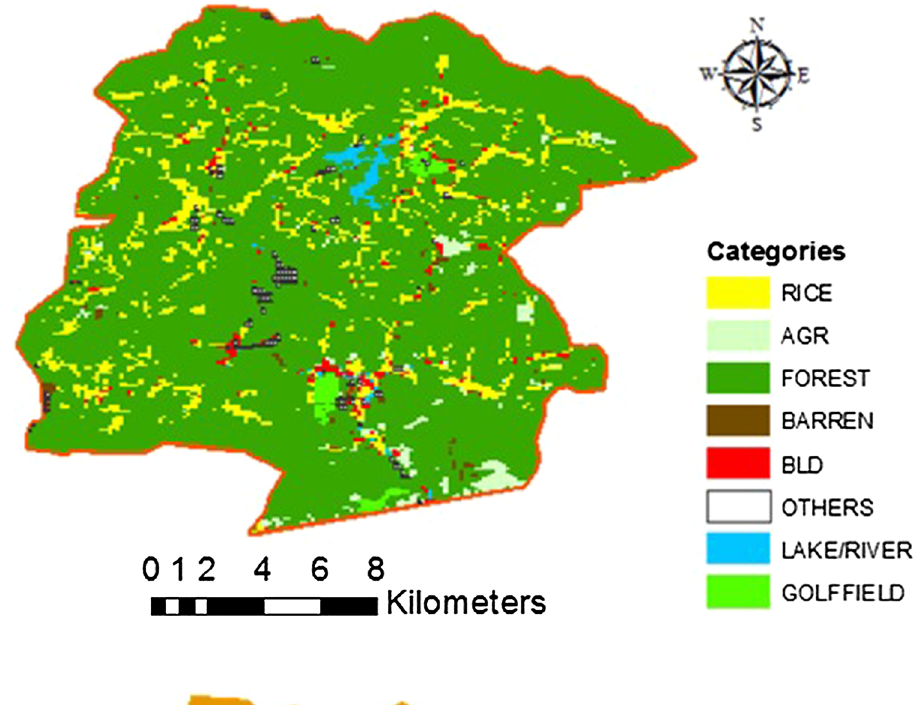
Fig. 4 Soil map of upstream Kase River